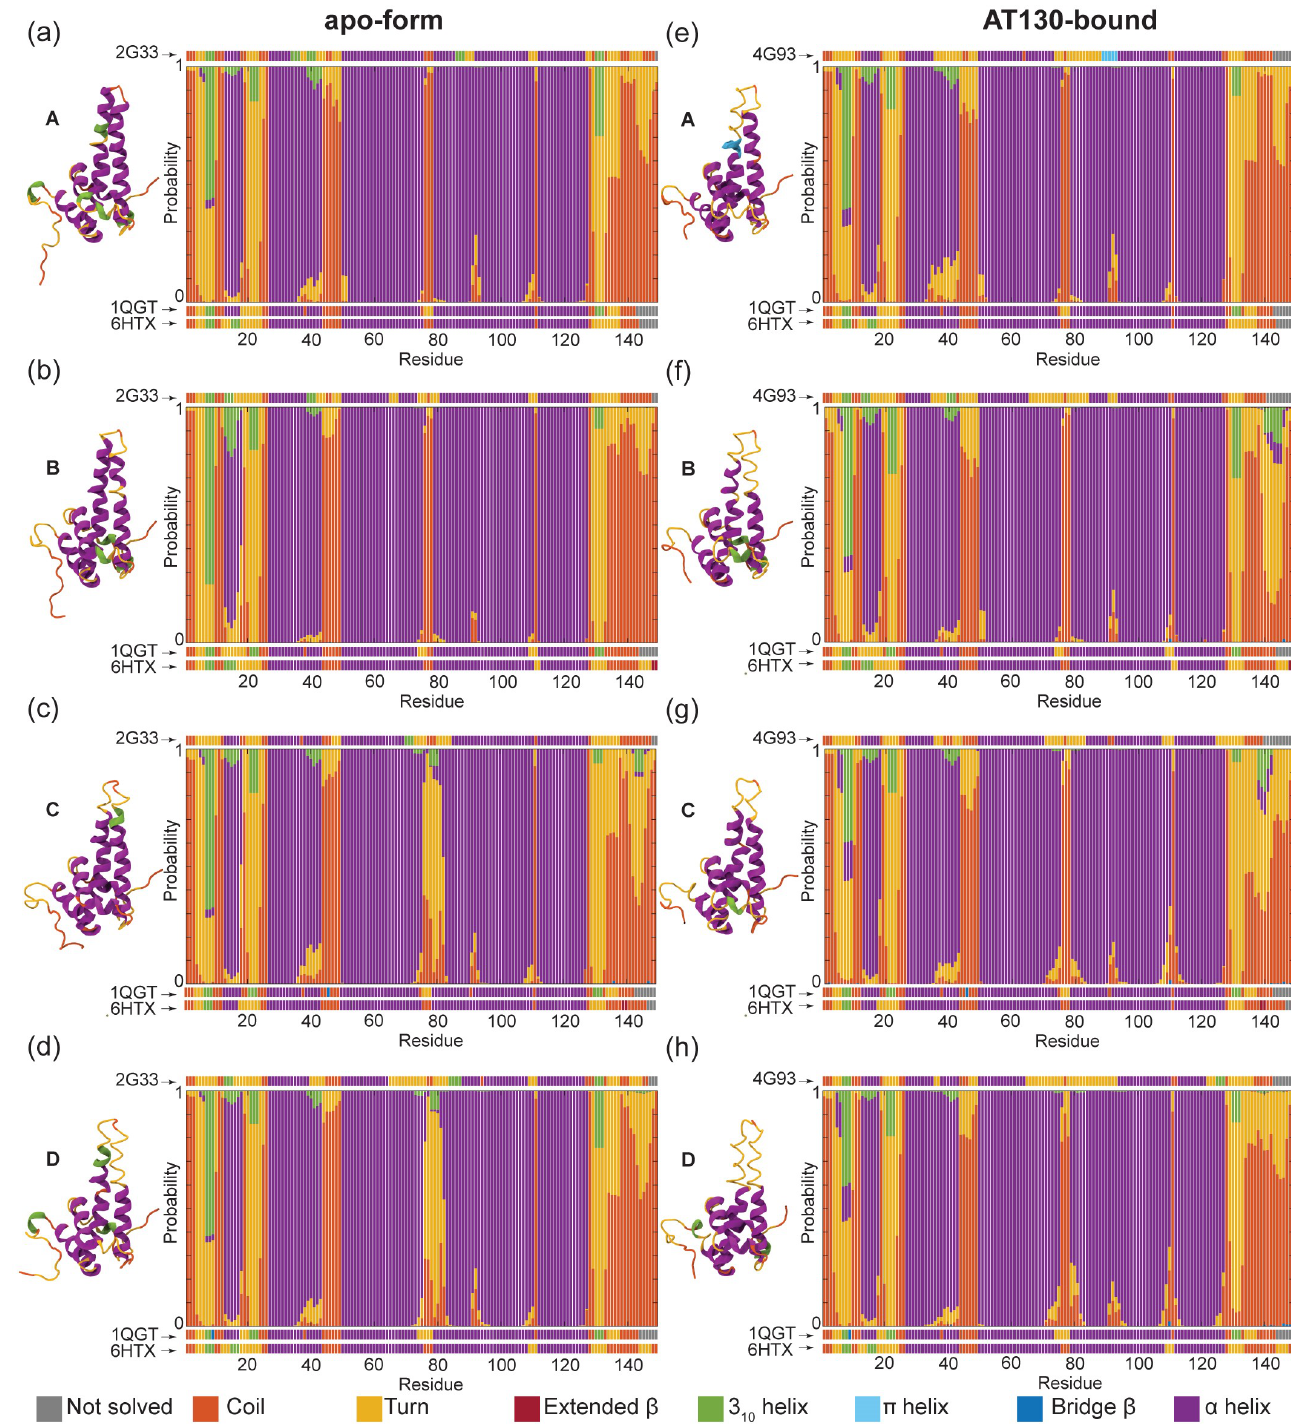
Figure 3. Secondary structure of capsid-incorporated dimers. ( a – d ) Chains A, B, C, and D of apo-form capsid (PDB 2G33, 3.96 Å). ( e – h ) Chains A, B, C, and D of AT130-bound capsid (PDB 4G93, 4.20 Å). Cartoon representation for each chain of crystal models shown, along with their secondary structure assignments according to STRIDE [34]. Histograms indicate probability of each Cp149 residue to be observed in a given secondary structure during MD simulations, calculated based on ensembles of three million conformers collected over 60 µ s of cumulative sampling. Purple denotes α -helix. Secondary structure of high resolution crystal structures (PDB 1QGT, 3.30 Å [4] and 6HTX, 2.66 Å [42]) provided for reference. During MD simulations of the apo-form capsid, the spikes of AB dimers were consis- tently ordered, with residues identified as helical in experimental structures exhibiting